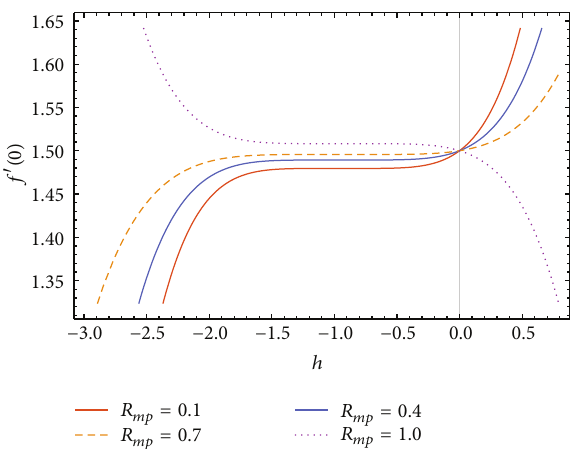
Figure 3: ℎ - curve of fifth-order solution for various 𝑅 𝑚𝑝 and 𝑚 ℎ = = 0.4 . 0.6 and 𝑚 𝑝